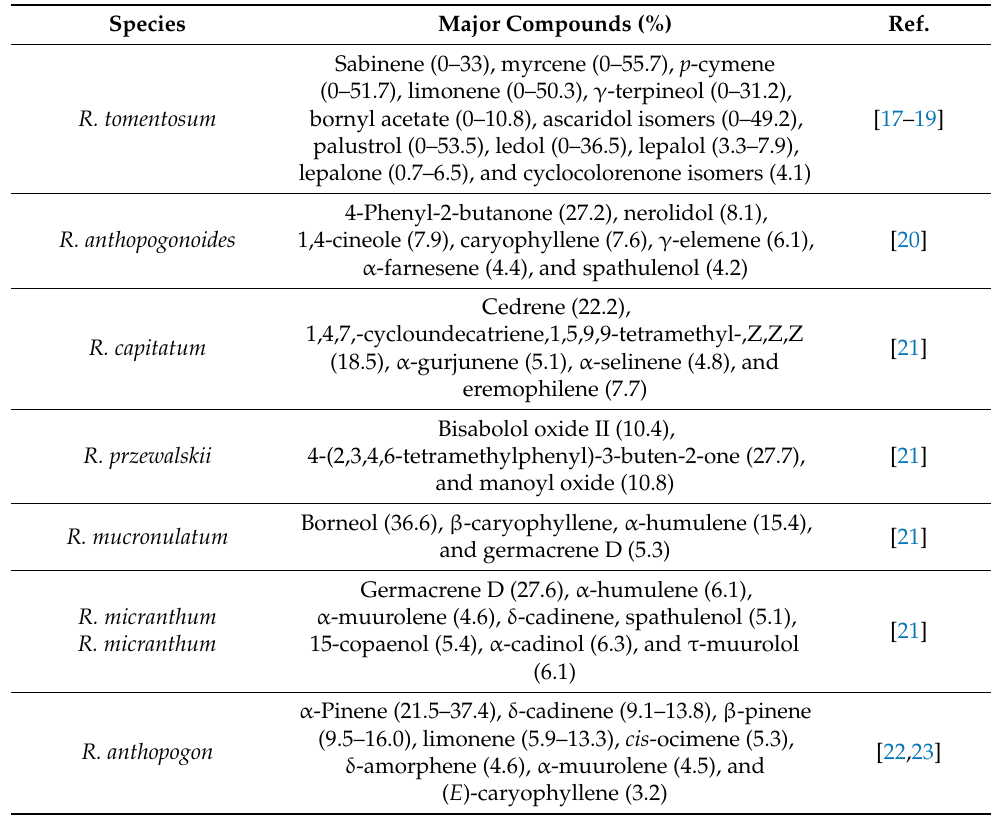
Table 1. Review of the major volatile constituents of Rhododendron essential oils. Species Major Compounds (%)